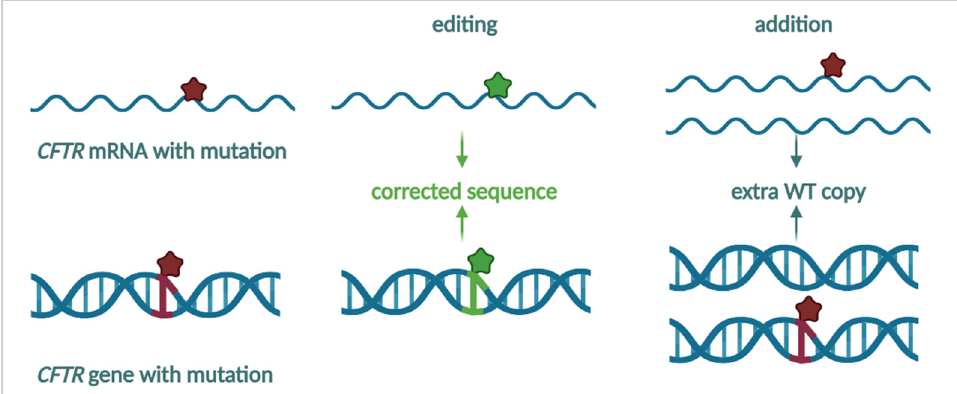
Figure 8. Strategies to produce wild-type (WT) CFTR by introducing the correct gene or mRNA sequence. The principles for the strategies for mRNA and DNA are identical, either the existing, mutated version is edited to the WT sequence, or a new correct exogenous copy is introduced into cells. Red star: sequence with mutation; green star: corrected sequence.